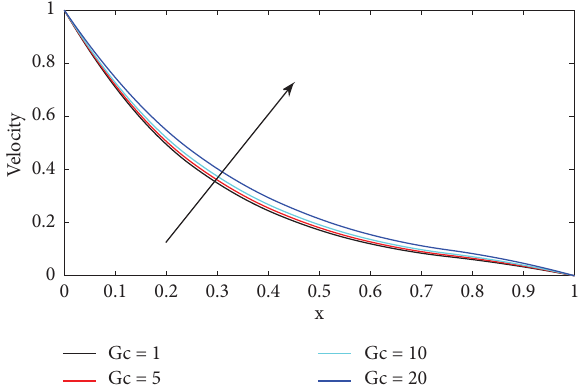
Figure 2: Velocity profles for diferent values of Gc .